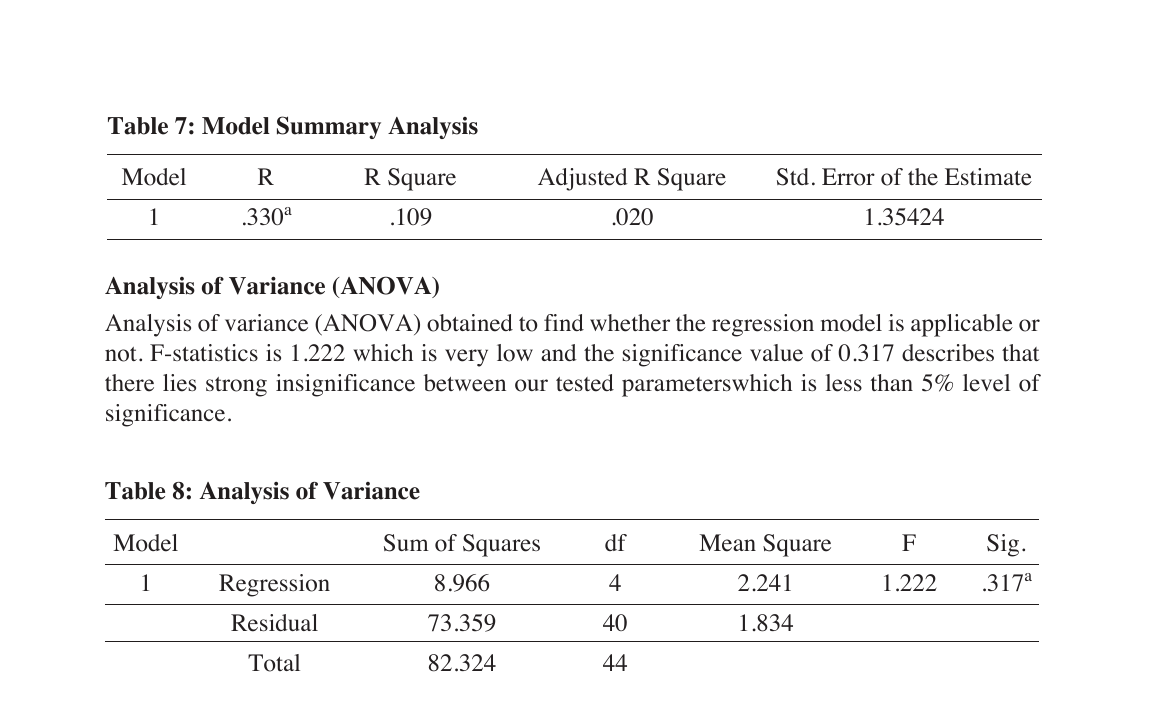
Analysis of Coefficient